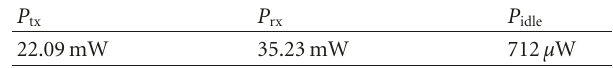
Table 2: IEEE 802.15.4 transceiver power consumption ( − 5